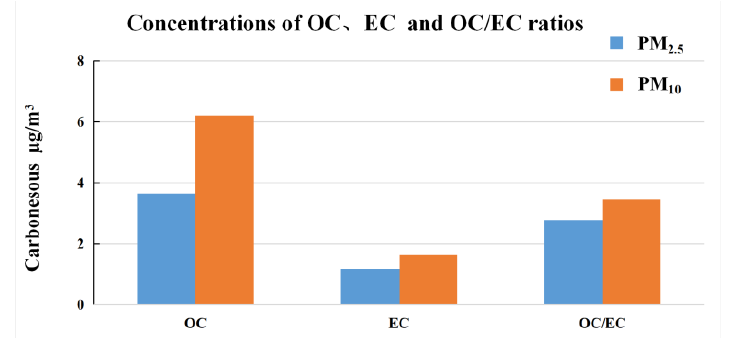
Figure 3. Monthly mean concentrations of organic carbon (OC) and elemental carbon (EC) and OC/EC ratio in PM 10 and PM 2.5 .